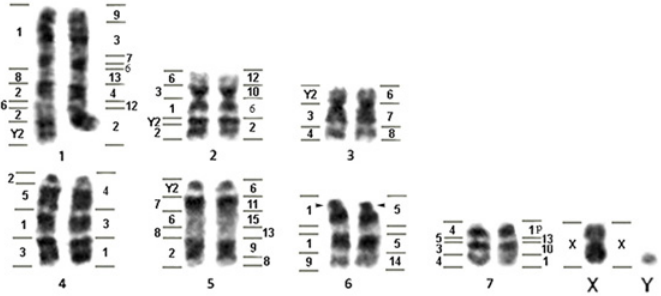
Fig 1. Tonatia saurophila G-banded karyotype showing homology to Carollia brevicauda (left) and Phyllostomus hastatus (right) chromosomes.